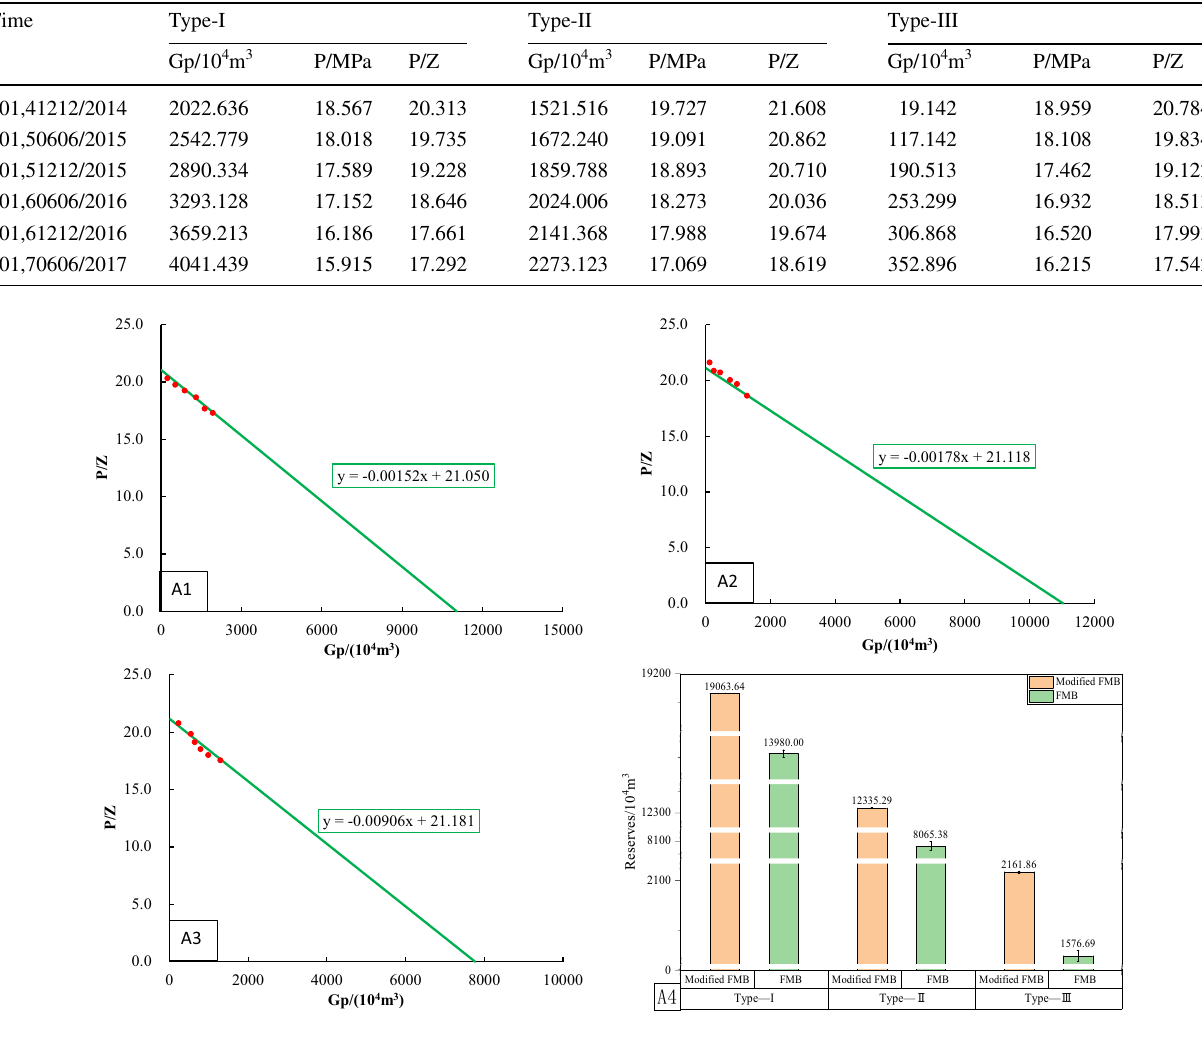
Table 5 Measured pressure of three wells Time